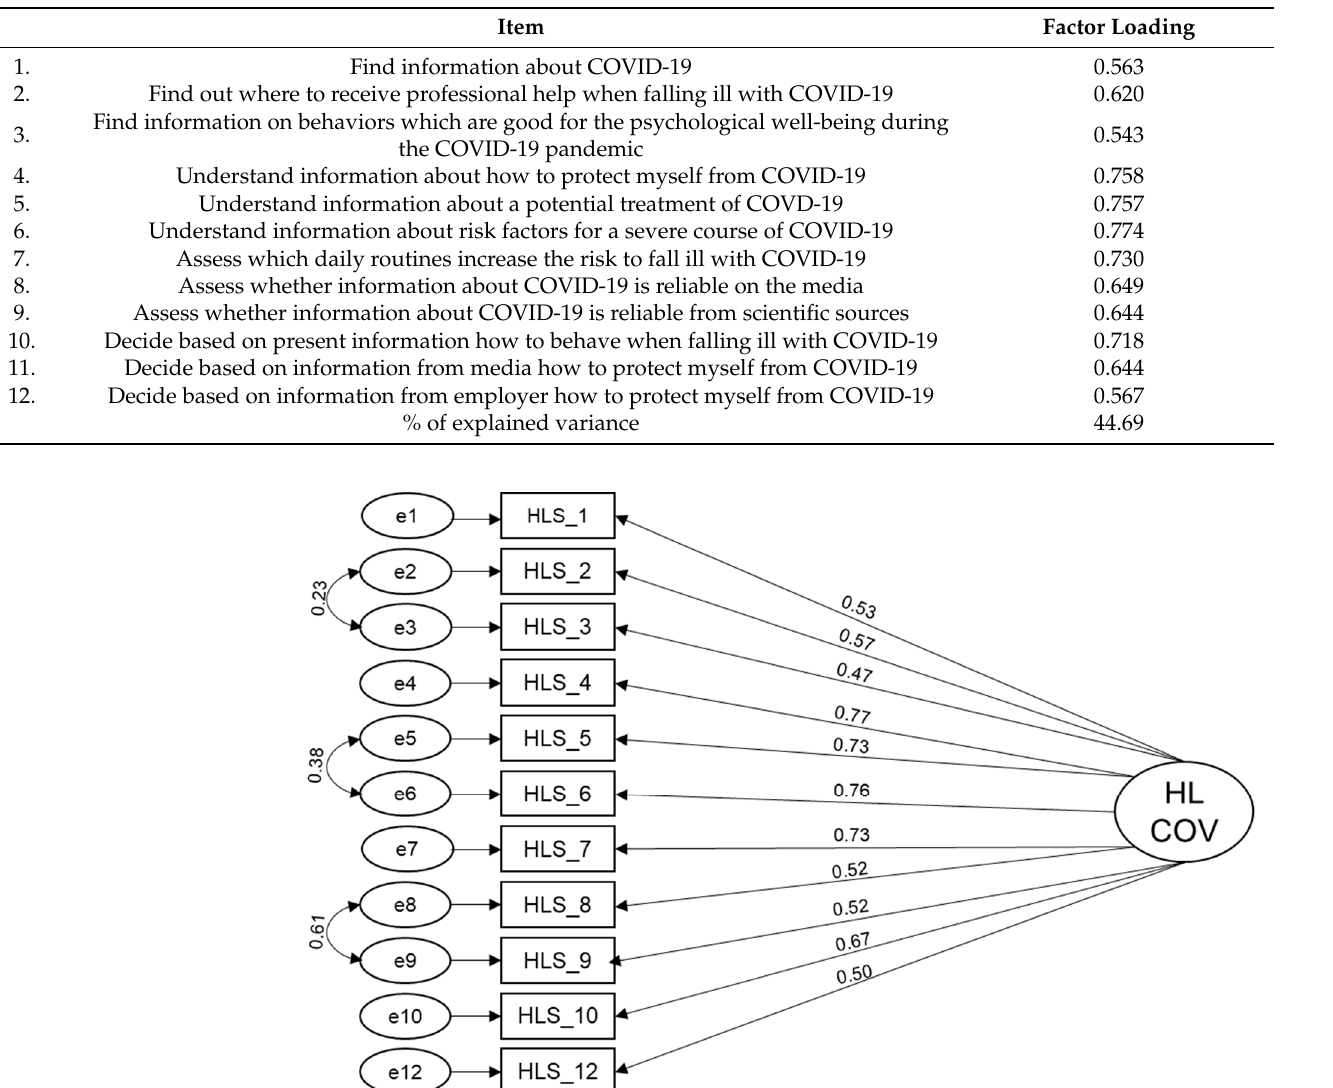
Table 3. Exploratory model of the HL-COV-HP instrument ( n = 965).